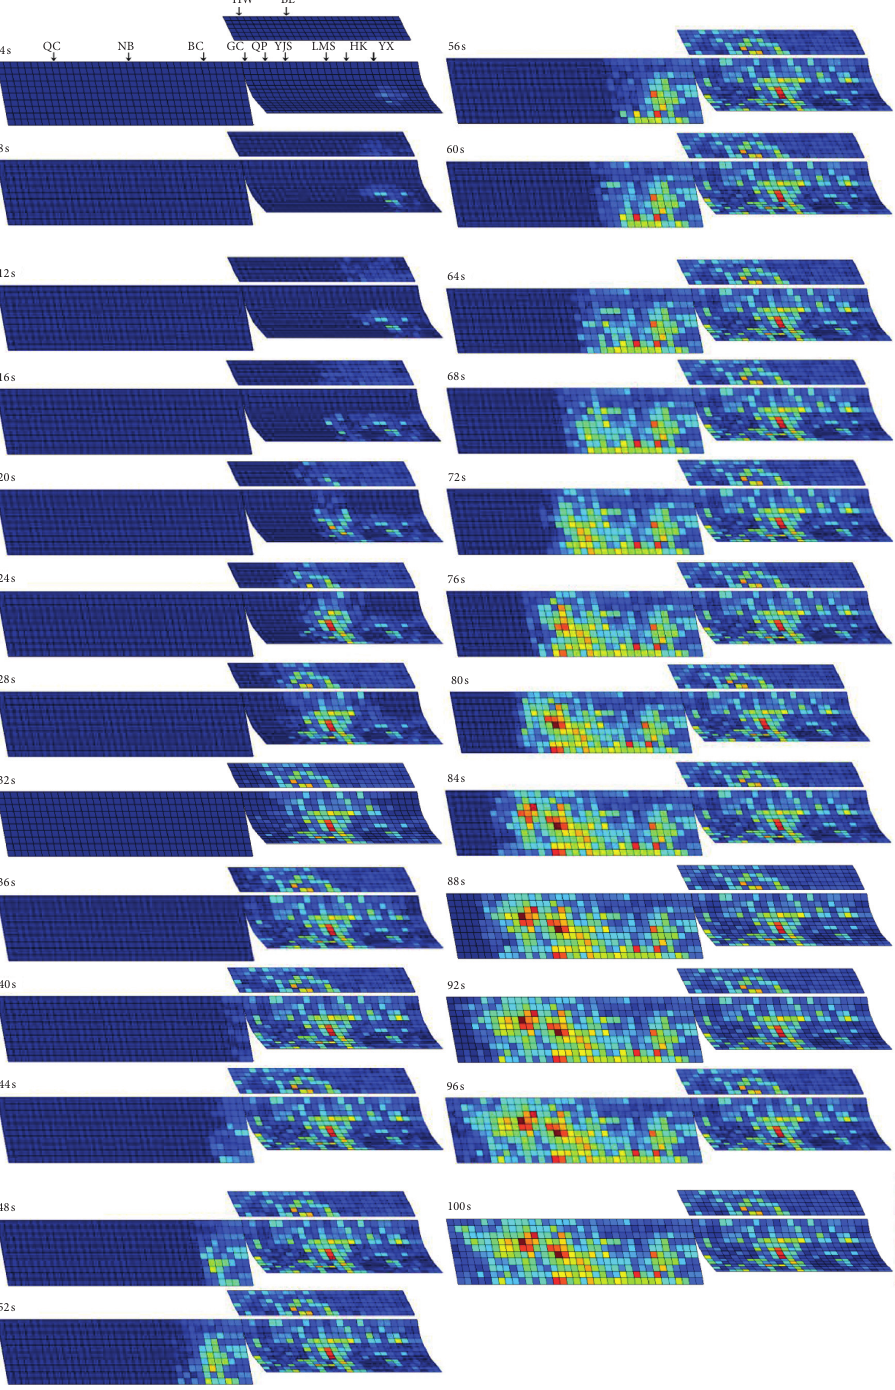
Figure 9: Rupture process snapshots with 4s